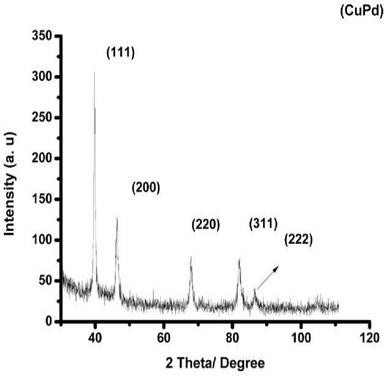
FT-IR spectra of (a): carboxyl-functionalized PNIPAM (b): thiolfunctionalized PNIPAM microgels.